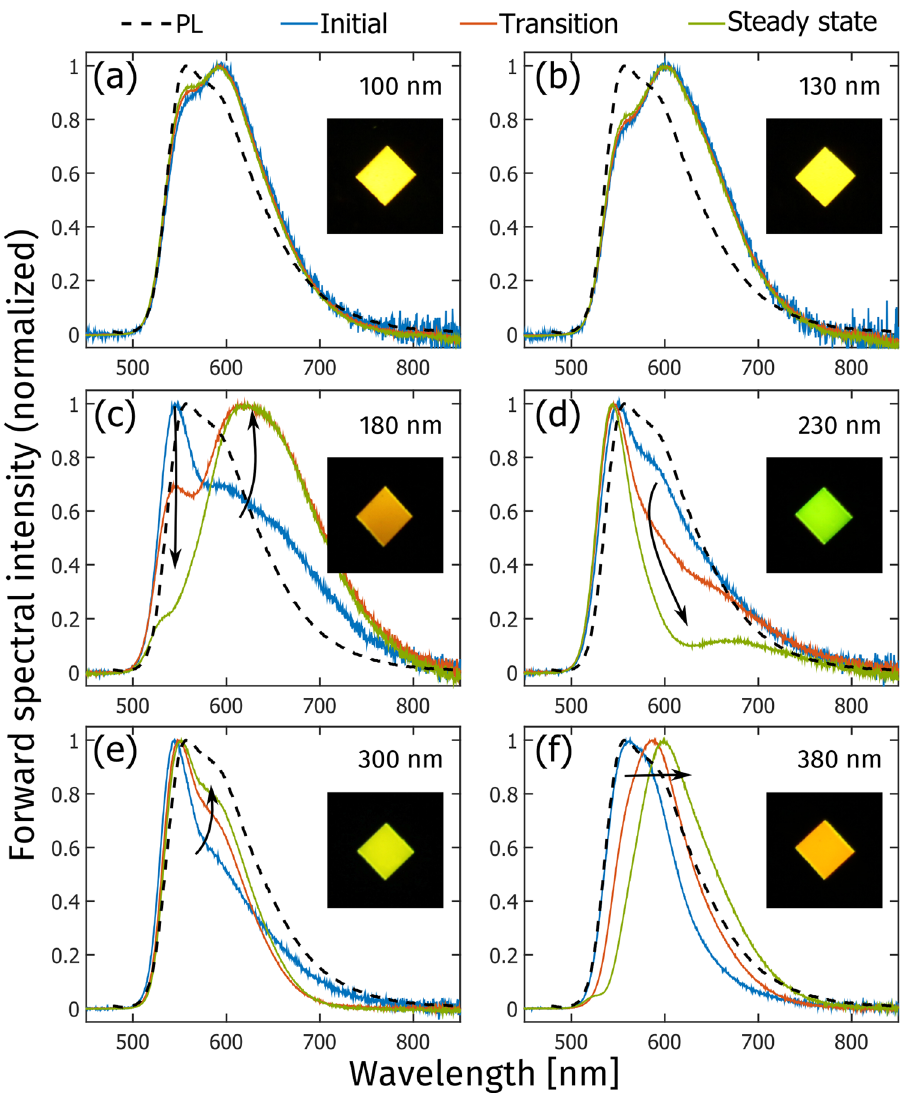
Figure 2. The temporal evolution of the normalized forward electroluminescence spectrum of LECs with different active-layer thickness, as identified in the upper right corner. The arrows and colors indicate increasing time from 1–2 min (initial, blue line), over 5–60 min (transition, red line), to 180 min (steady-state, green line). The photoluminescence spectrum of a thin film of the conjugated-polymer emitter, Super Yellow, is included as the black dashed line for reference. The inset photographs show the corresponding forward emission color during steady-state